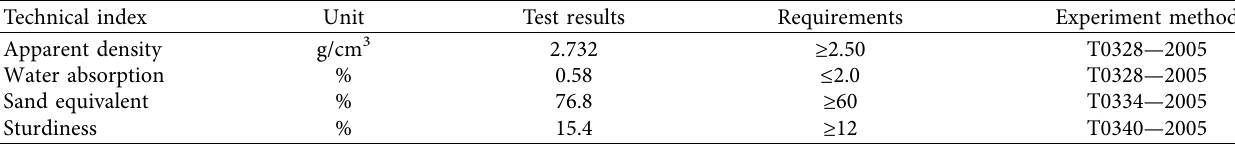
Table 12: Limestone fne aggregate performance index.